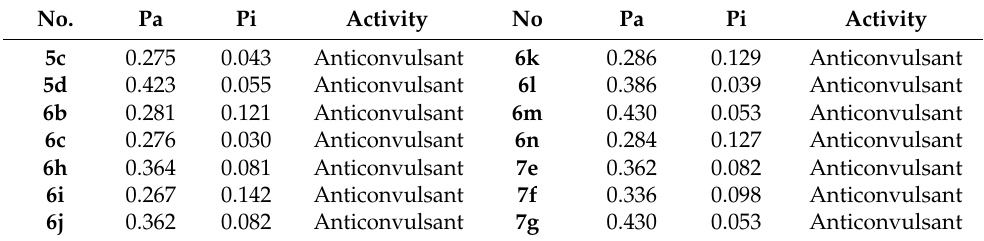
Table 2. PASS prediction results.